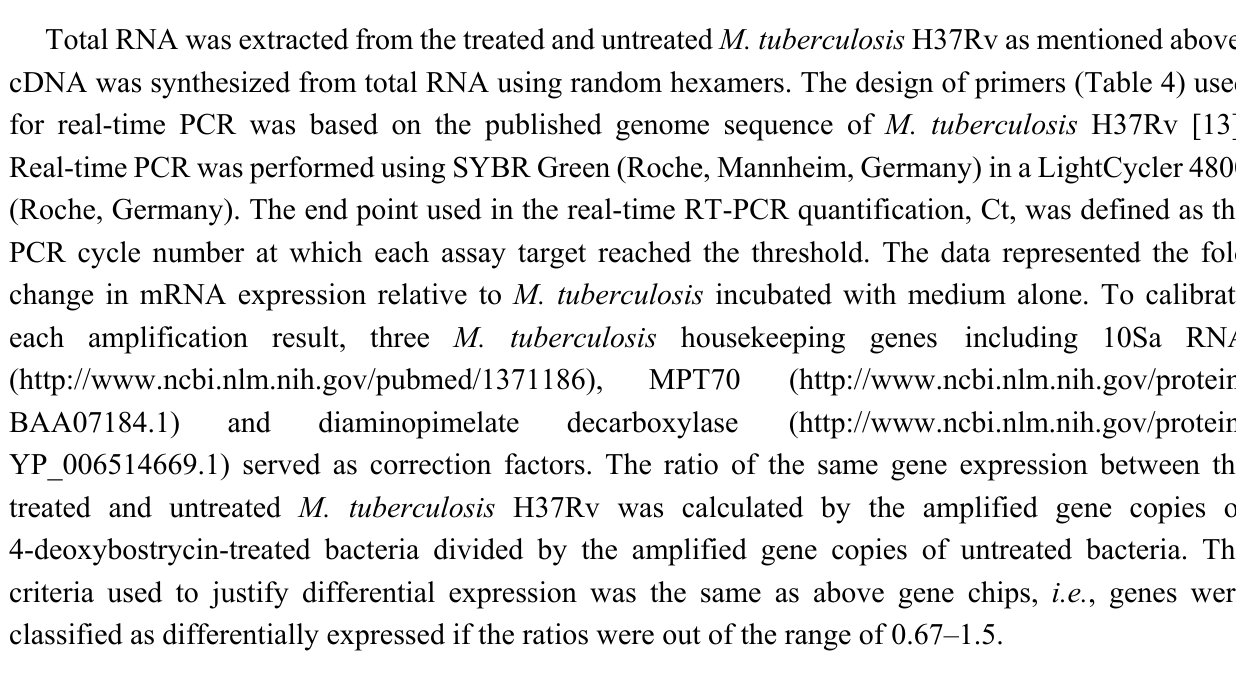
Table 4. The primers of